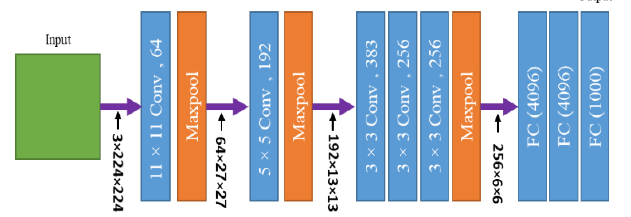
Figure 5. The architecture of